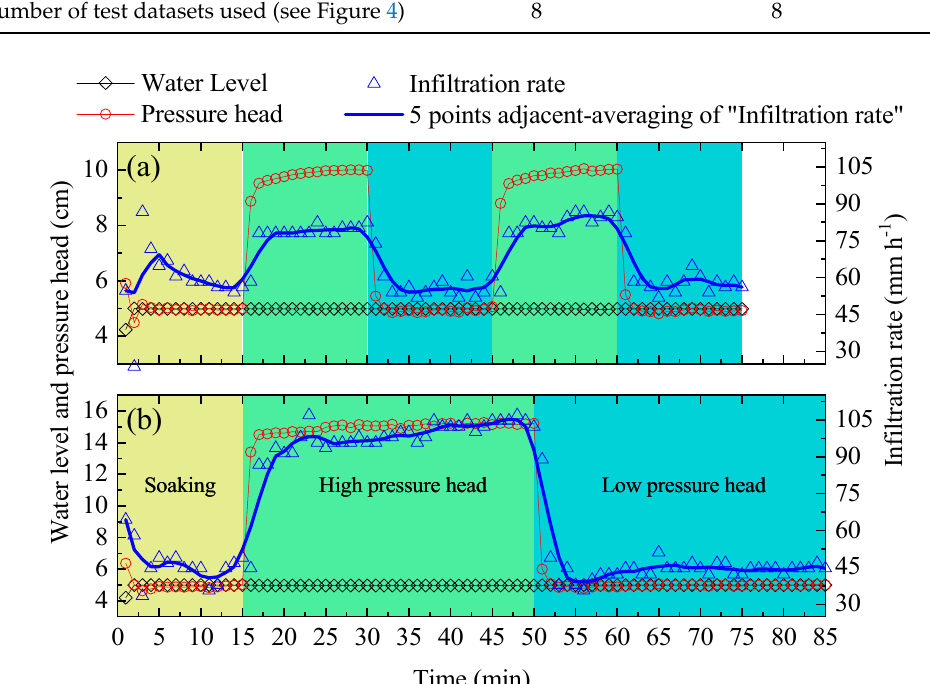
Figure 3. Examples of the raw data recorded during measurements using a DHI with ( a ) the default parameters and ( b ) the optimized parameters, as given in Table 2. The “5 points adjacent-averaging” line smoothed the data by averaging consecutive data points within a moving window of five points. Table 2. Characteristics of eight infiltration processes with different measurement settings (default vs. optimized). CV_PH and CV_PL are the coefficients of variation (CV) for high and low pressure heads, respectively. CV_IH and CV_IL are the CVs for infiltration rates at high and low pressure heads, respectively. |Slp_H| and |Slp_L| are the absolute values of the linear regression slopes of the infiltration rate over time at high and low pressure heads, respectively. Different letters indicate a significant difference at α = 0.05.